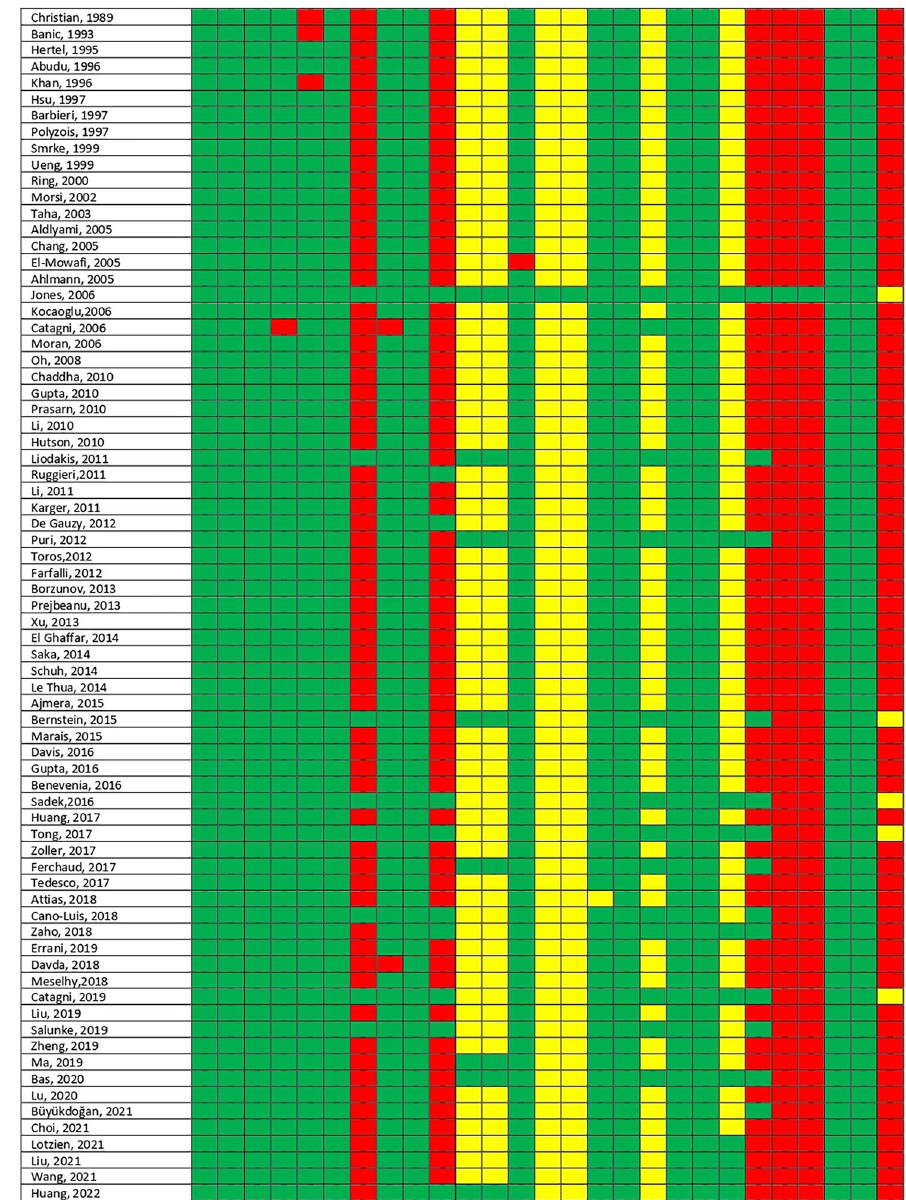
Figure 3. Risk of bias of all the included studies, evaluated in accordance with the “Downs and Black’s tool for assessing the risk of bias”.